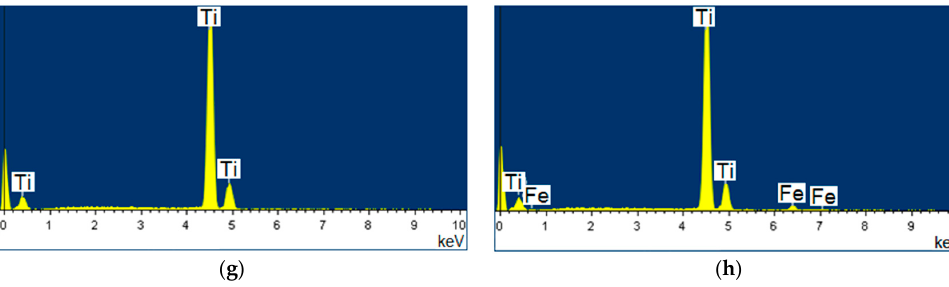
Figure 9. Micrographs of the coating cross-section and EDS results: specimen produced in regime No. 7 ( a – d ) and No. 8 ( e – h ). A circle within red rectangle shows the location where EDS analysis was carried out.